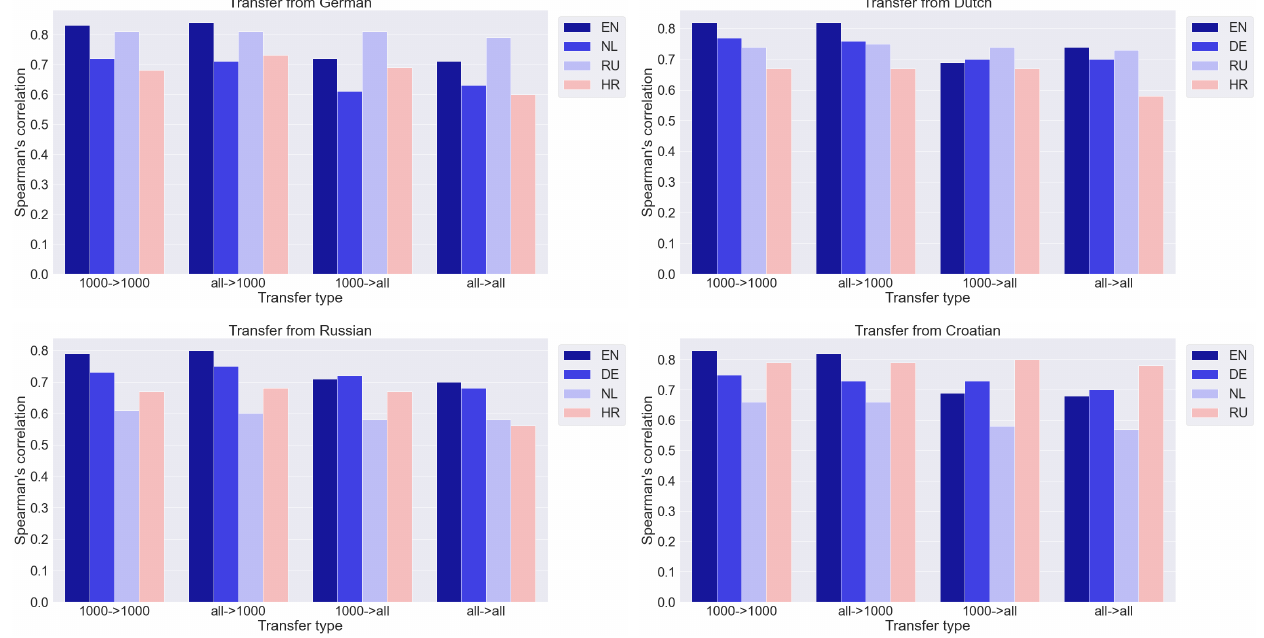
Figure 4. Results of transfer from different